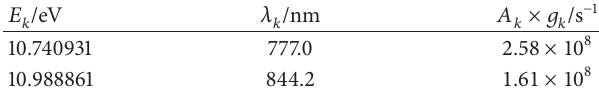
Table 2: Spectra constants of O atoms at 777.0 and 844.2 nm [20].